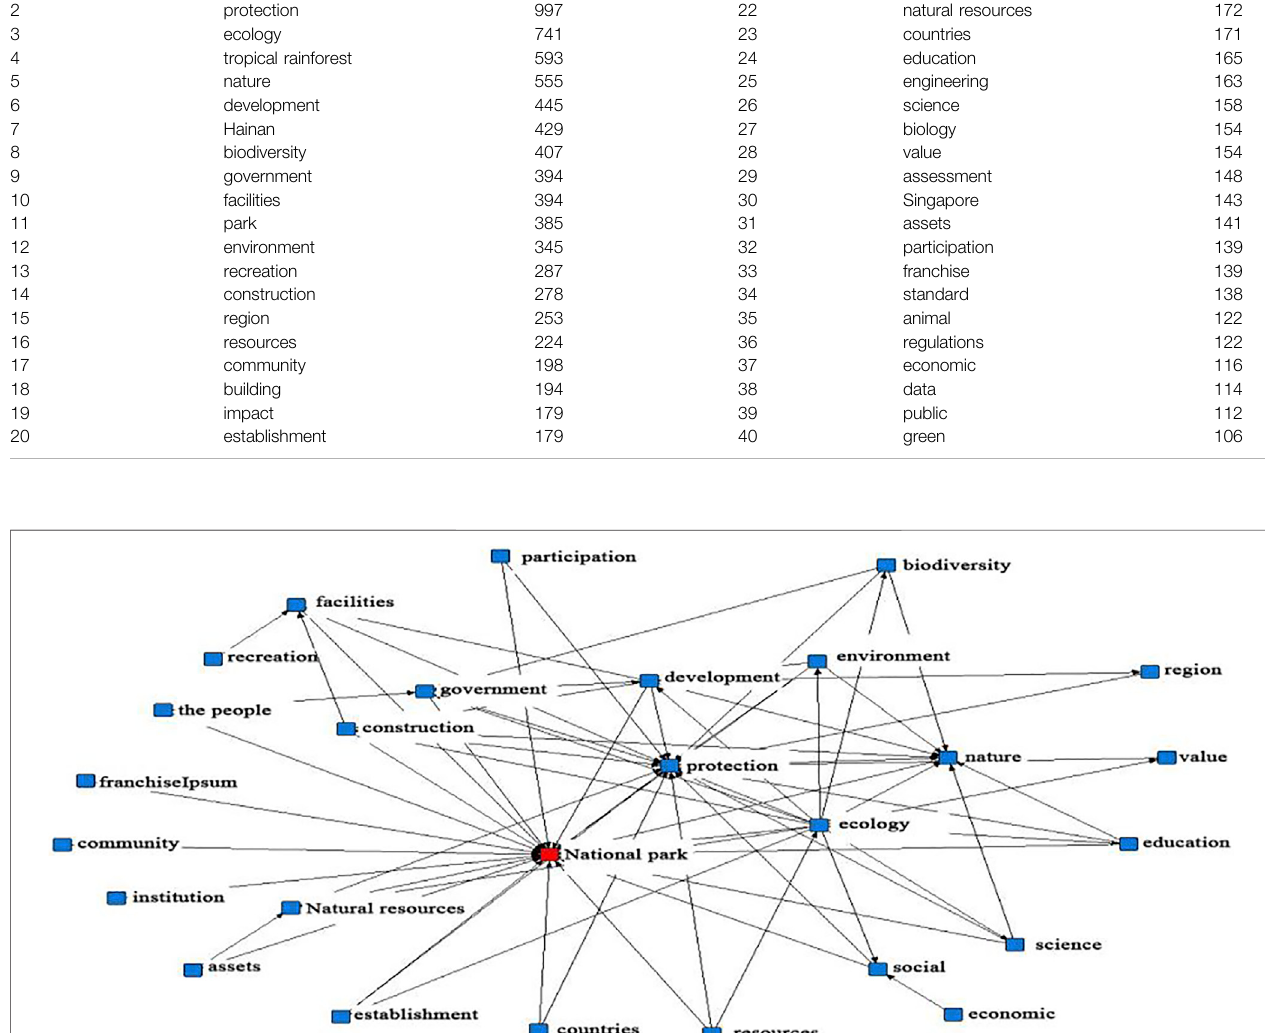
Frontiers in Environmental Science |